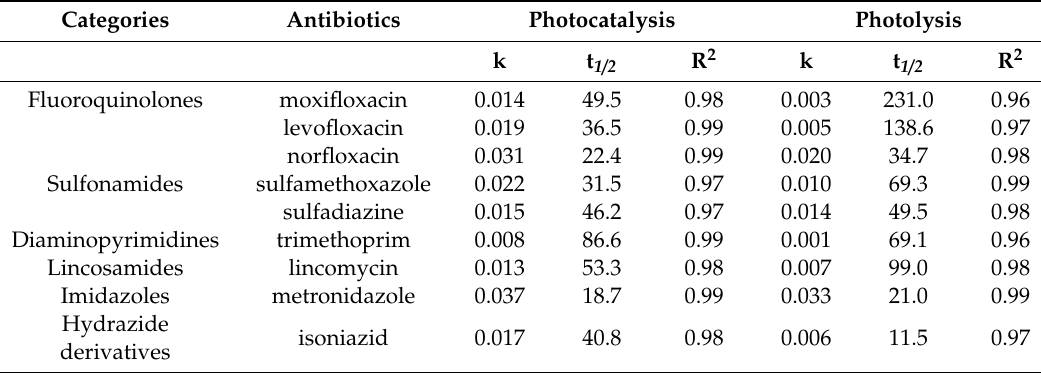
Table 1. Kinetic data during photolysis and photocatalysis of antibiotic mixture (C 0(drug) = 1 mgL –1 , PLLA–